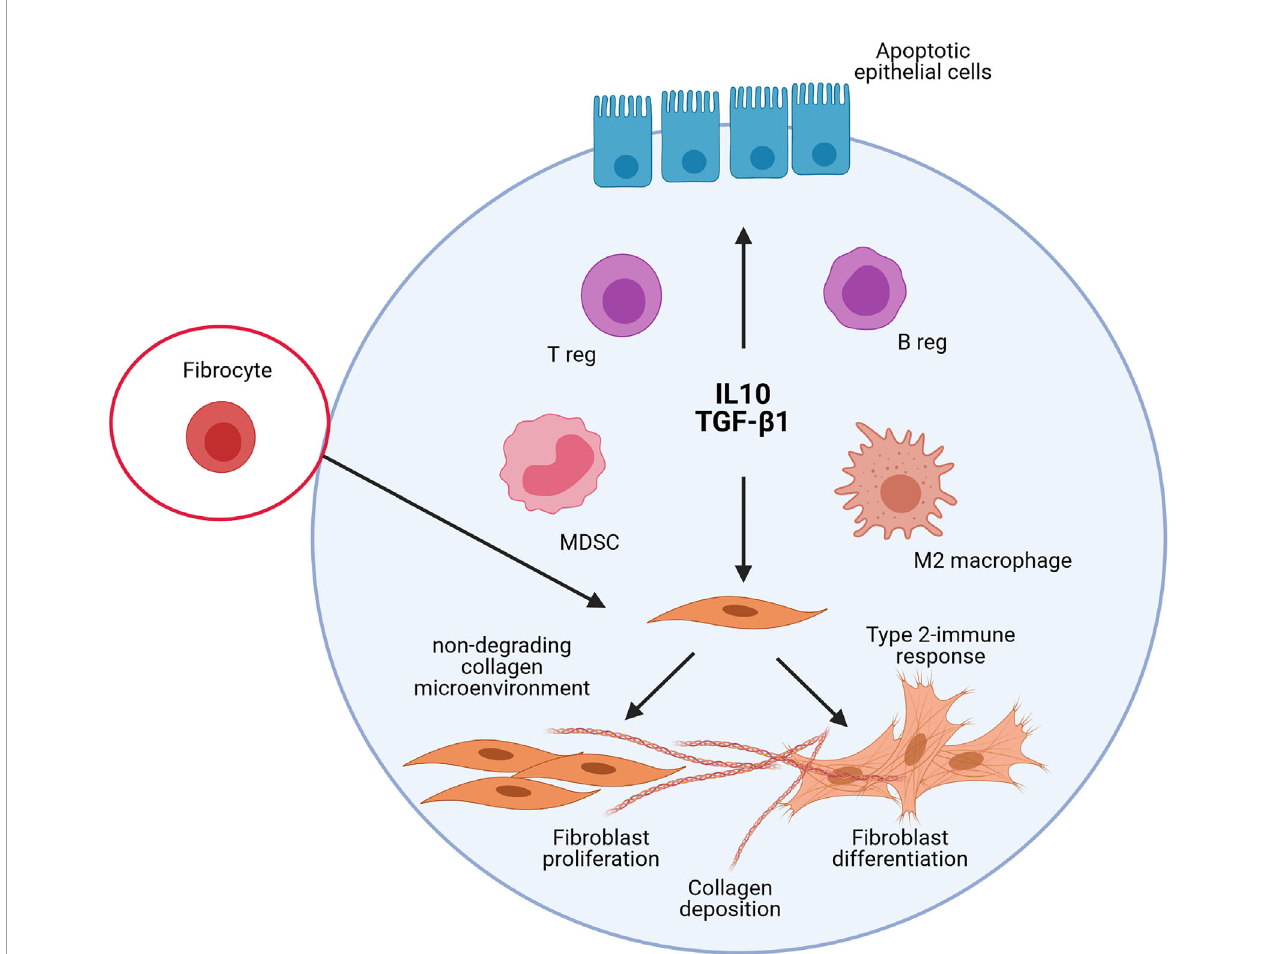
FIGURE 3 | Schematic representation of the implication of the different immunoregulatory cells and mediators in lung fi brosis. The studies on experimental lung fi brosis have highlighted a new pathological pathway, which suggests that pulmonary fi brosis is orchestrated by an immunoregulatory response characterized by a persistent accumulation of pulmonary immunoregulatory cells (regulatory T and B lymphocytes, i.e. T and B regs; regulatory myeloid cells, i.e. M2/ immunosuppressive macrophages and Myeloid Derived Suppressive Cells, MDSC) and a sustained production of IL-10 and TGF- b 1. The persistent accumulation of these elements to control immunostimulatory responses in the lungs contribute, however, to pulmonary fi brosis. This sustains the view that immunoregulation is important pro- fi brotic environment that could markedly explain the development of the lung fi brotic response under non-in fl ammatory